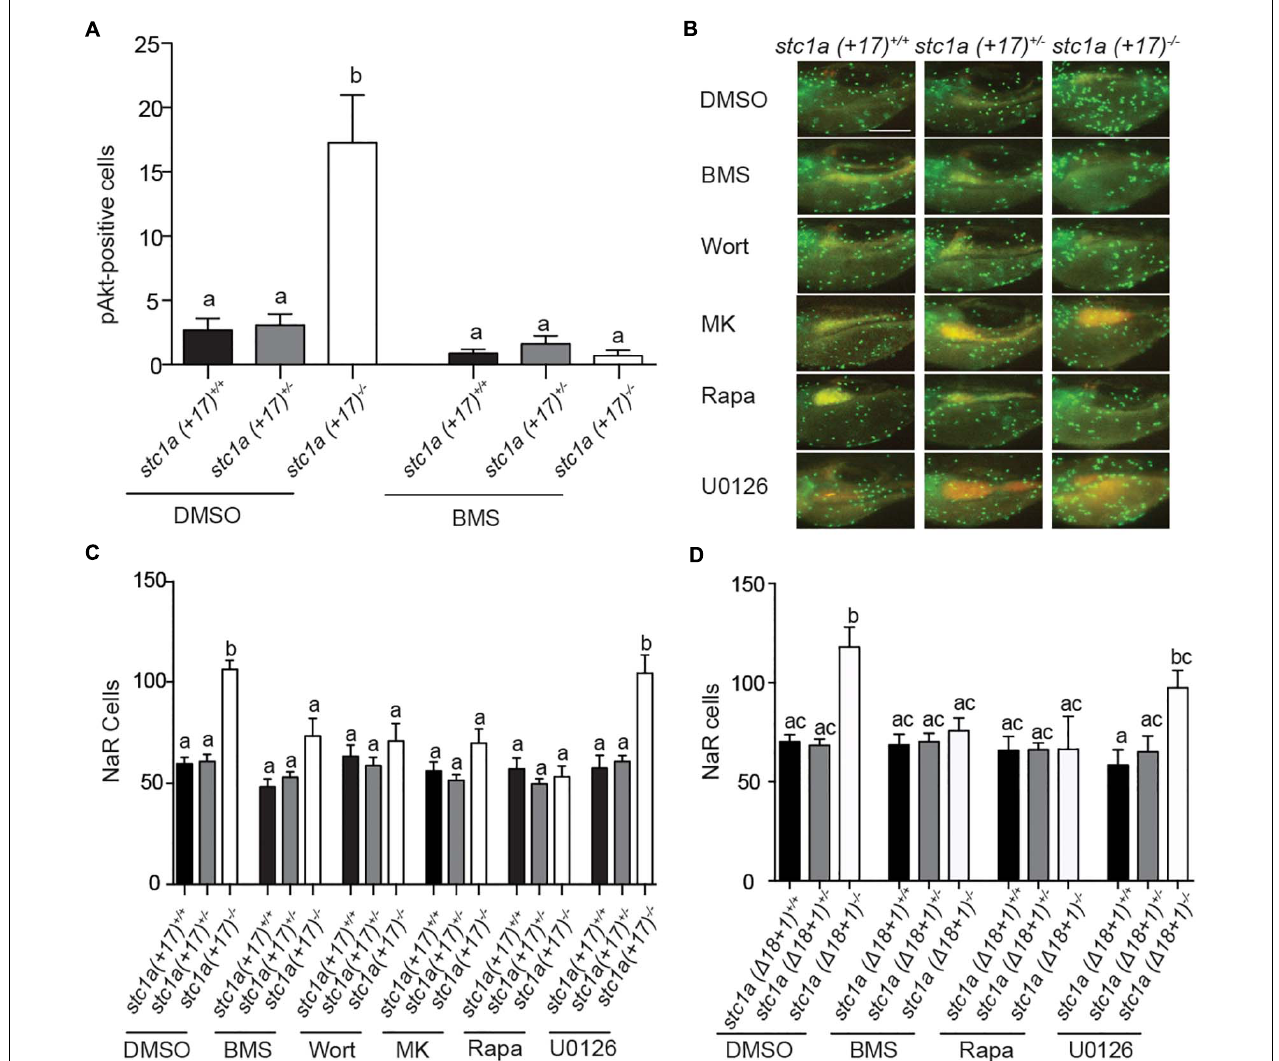
FIGURE 5 | Stc1a promotes NaR cell quiescence by suppressing IGF-PI3 kinase-Akt-Tor signaling in NaR cells. (A) Progenies of stc1a ( + 17) + / − ; Tg (igfbp5a: GFP) intercrosses were raised in E3 embryo medium to 3 dpf and treated with DMSO or 0.3 µ M BMS-754807 (BMS). Two days later, fish were fixed and phospho-Akt positive cells in the yolk sac region were detected by immunostaining. These fish were genotyped individually afterward. n = 14–47 larvae/group. (B,C) Progeny of stc1a ( + 17) + / − ; Tg (igfbp5a: GFP) intercrosses were raised in E3 embryo medium and treated with DMSO, 0.3 µ M BMS-754807 (BMS), 0.06 µ M Wortmannin (Wort), 8 µ M MK2206 (MK), 5 µ M Rapamycin (Rapa), or 10 µ M U0126 from 3 to 5 dpf. After NaR cells were quantified, these fish were genotyped individually. Representative images (B) and quantified data are shown (C) . n = 7–35 larvae/group. Scale bar = 0.2 mm. (D) Progeny of stc1a ( (cid:49) 18 + 1) + / − ; Tg (igfbp5a: GFP) intercrosses were raised in E3 embryo medium to 3 dpf and treated with DMSO, 0.3 µ M BMS-754807 (BMS), 5 µ M Rapamycin (Rapa), or 10 µ M U0126 from 3 to 5 dpf. NaR cells were quantified as described above. n = 4–28